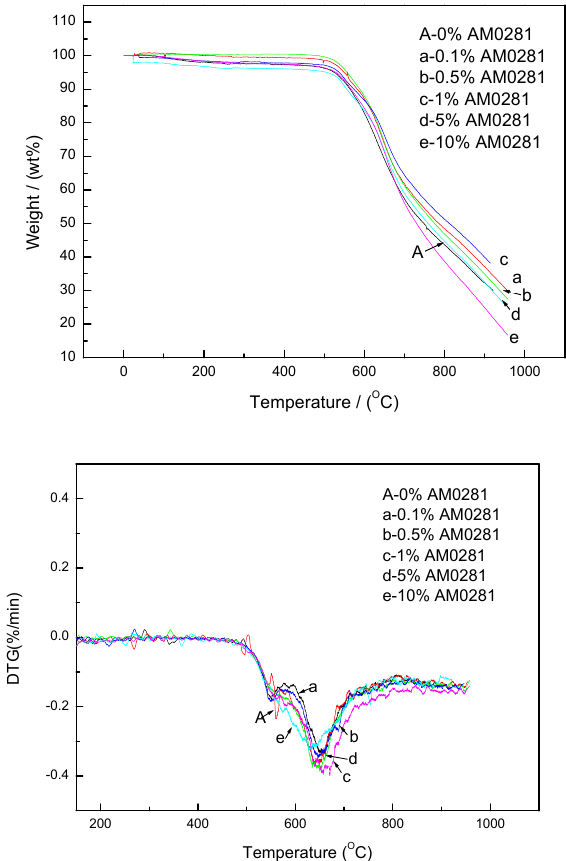
Figure 5. TGA and DTG plots of the neat polymer and the polymers with different AM0281 contents under an air atmosphere.